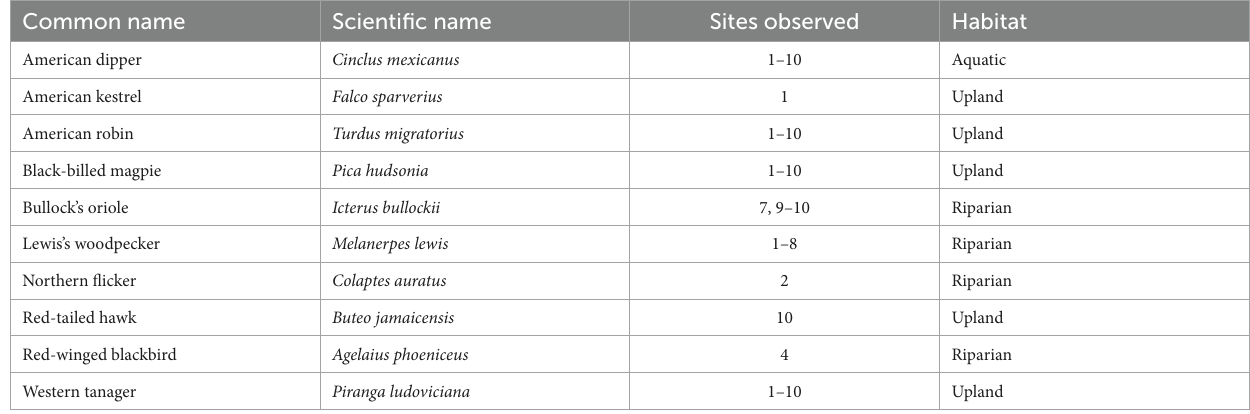
TABLE 3 Species observed capturing and feeding on adult giant salmonflies in the Salmon River Basin and Henry’s Fork of the Snake River, Idaho, United States in May–June